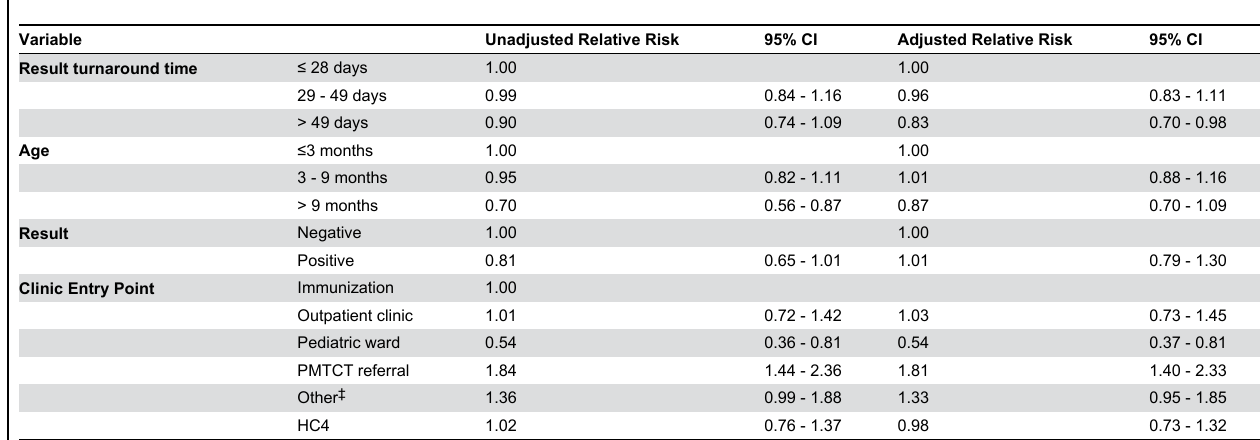
Table 3. Unadjusted and Adjusted Analysis of Result Receipt at the Level Four Health Center and Regional Referral